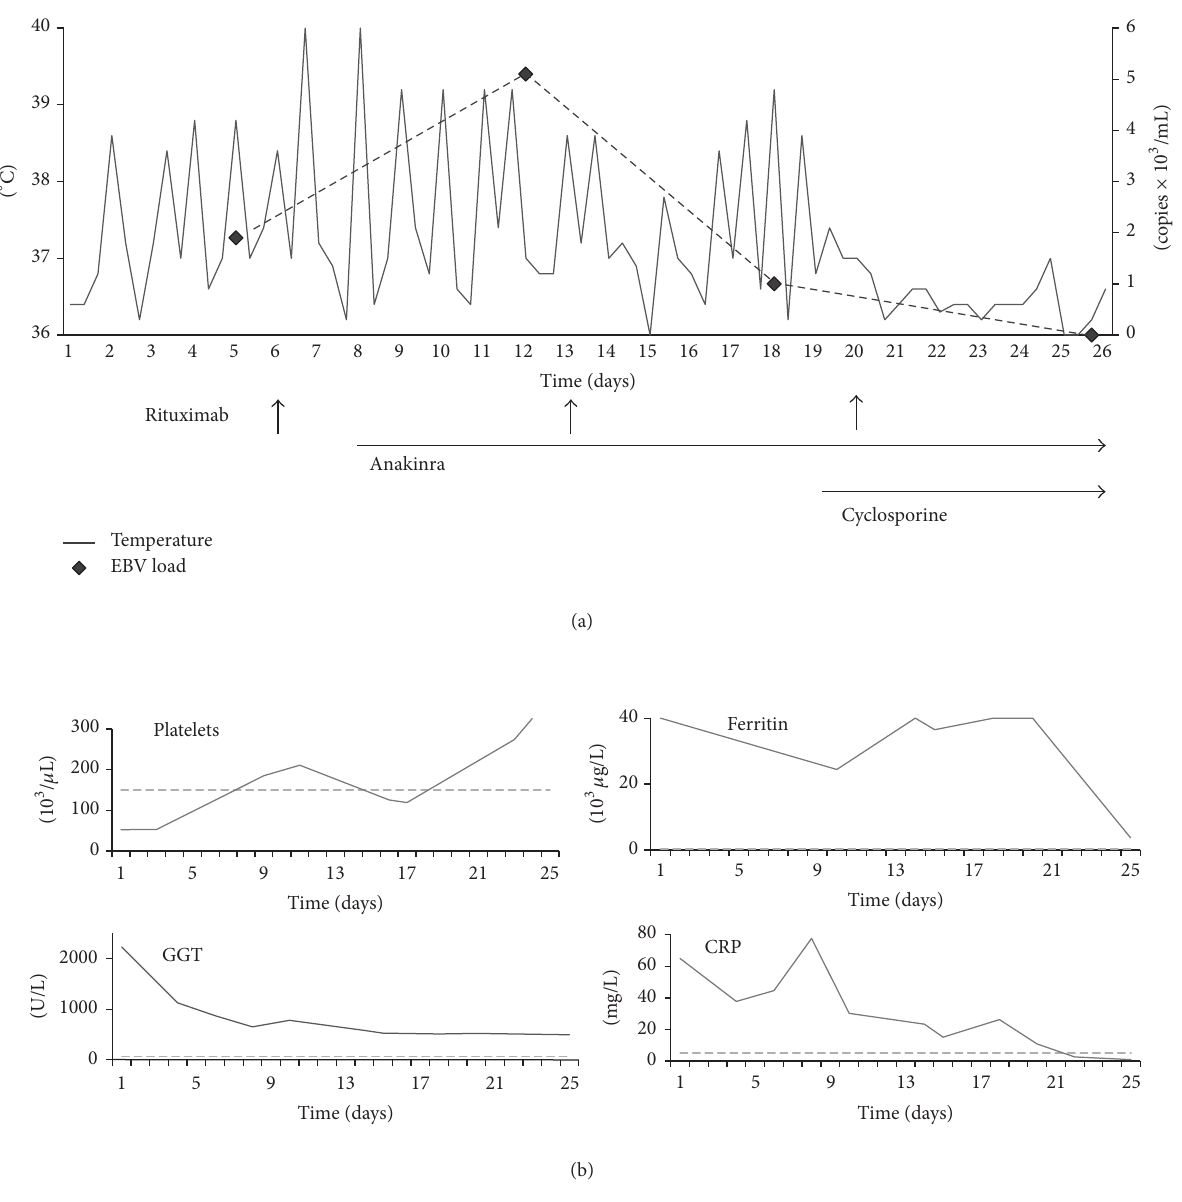
Figure 1: Clinical response in relation to treatment with rituximab, anakinra, and cyclosporine. (a) Fever curve and treatment overview. Body temperature was taken twice a day via an infrared ear thermometer. Rituximab was started on day 6 at a dose of 375mg/m 2 and repeated once a week indicated by an arrow until virus suppression was achieved after the third infusion. Anakinra was started on day 8 at a dose of 100mg daily and cyclosporine on day 19 at a dose of 200mg daily (blood level aiming at 100 𝜇 g/L). (b) Correlating laboratory parameters over time. Dotted lines indicate the respective upper reference ranges. CRP: C-reactive protein; EBV: Epstein-Barr virus; GGT: